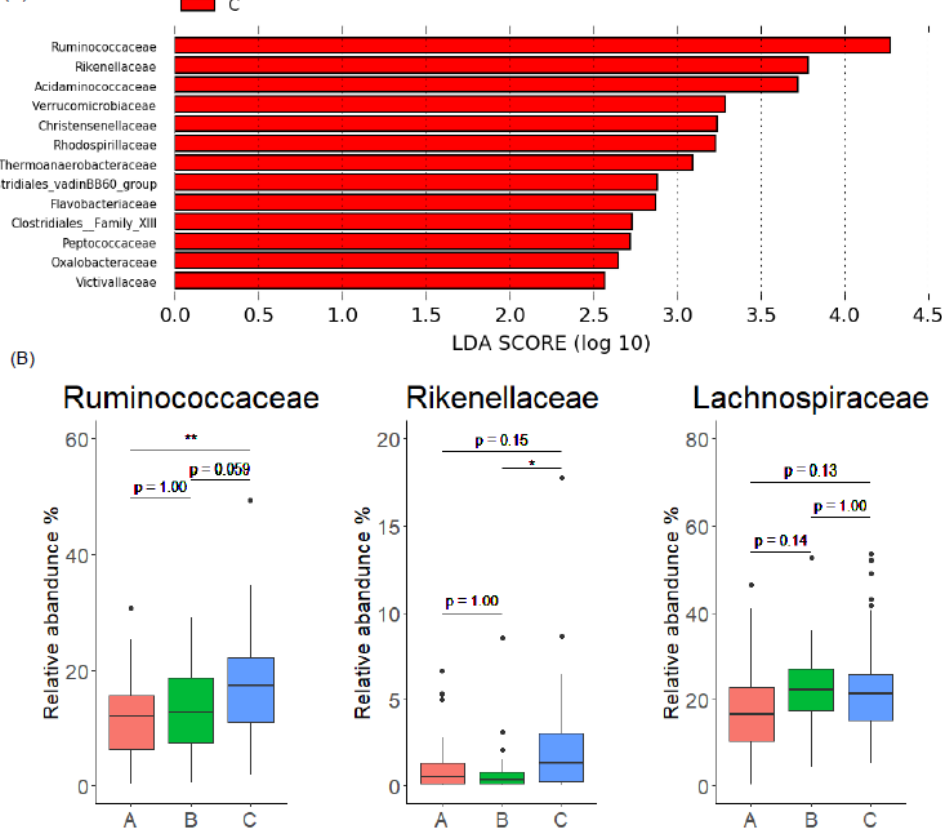
Figure 4. Comparison of gut microbiome composition at family level between EL producers and non − producers. ( A ) LEfSe analysis at family level comparing EL producers (Group C) and EL non − producers (Group B). ( B ) Comparison of relative abundance of Ruminococcaceae, Rikenellaceae, and Lachnospiraceae of EL producers (Group C) and other groups. In the box plots, the boundary of the box closest and farthest to zero indicates the 25th and 75th percentile, respectively, and a black line within the box marks the median. Whiskers indicate minimum and maximum values. Points above the whiskers indicate outliers. Statistical significance was evaluated by Kruskal-Wallis test followed by Bonferroni ’ s multiple comparison test. * p < 0.05, and ** p < 0.01.